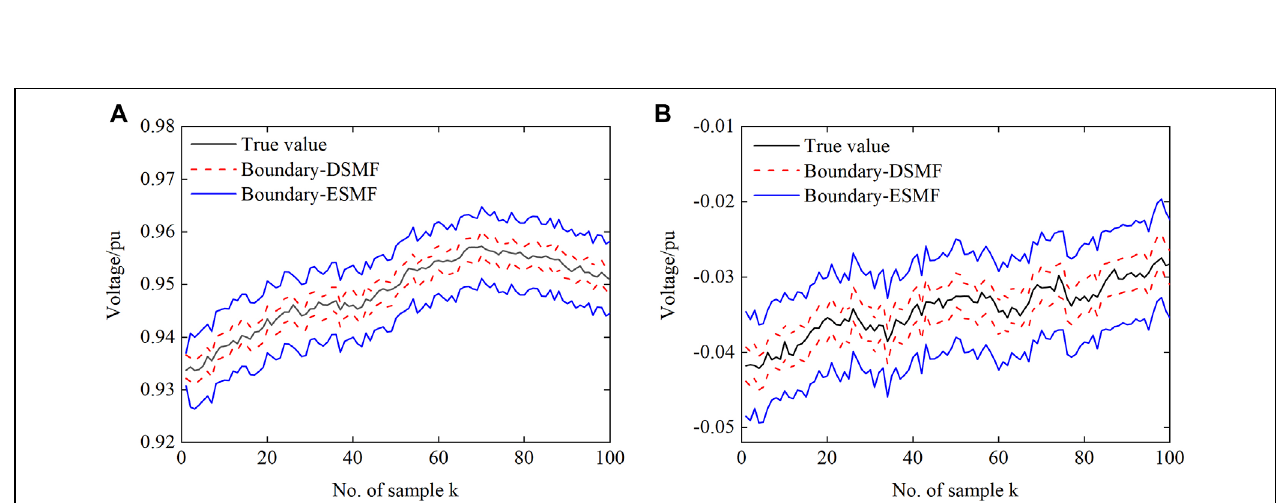
Frontiers in Energy Research |